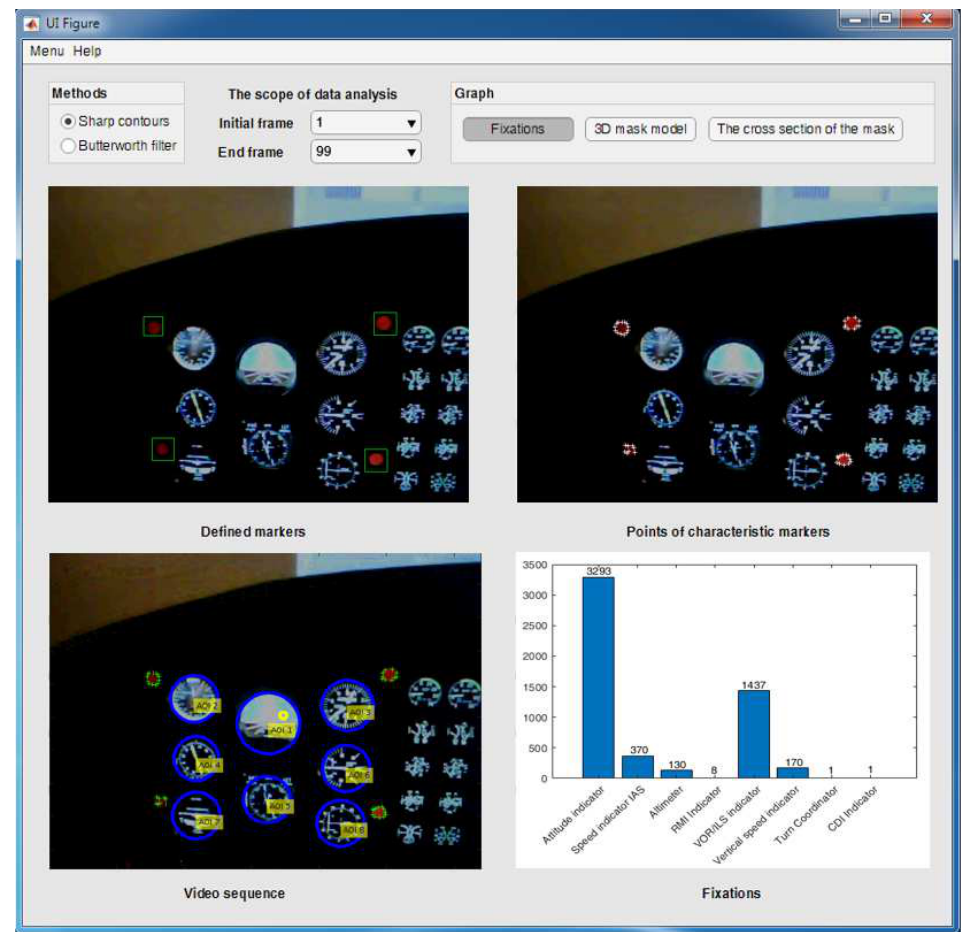
Figure 9. Smart Trainer application interface.